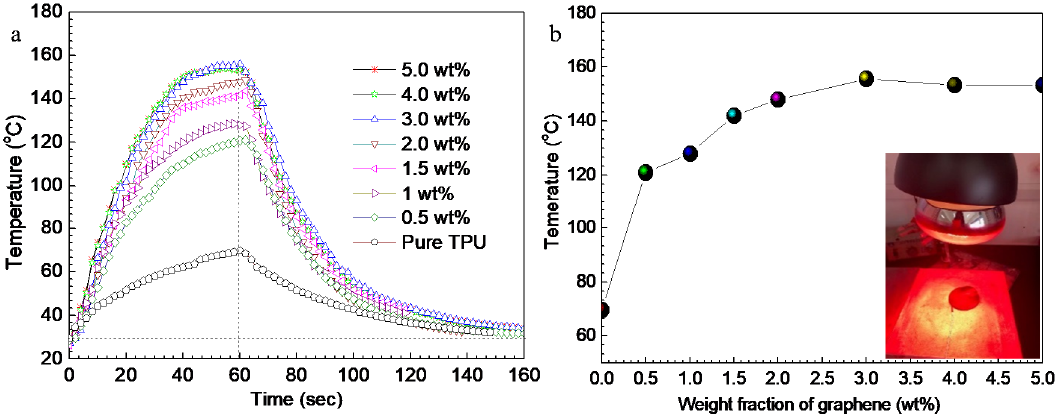
Figure 8. ( a ) Time-dependent temperature of the composite films with different mass contents of graphene via IR light, and ( b ) maximum temperature of the composite film heated for 60 s via IR light-dependent the mass content of graphene. The inset in (a) shows photo of the tested sample.